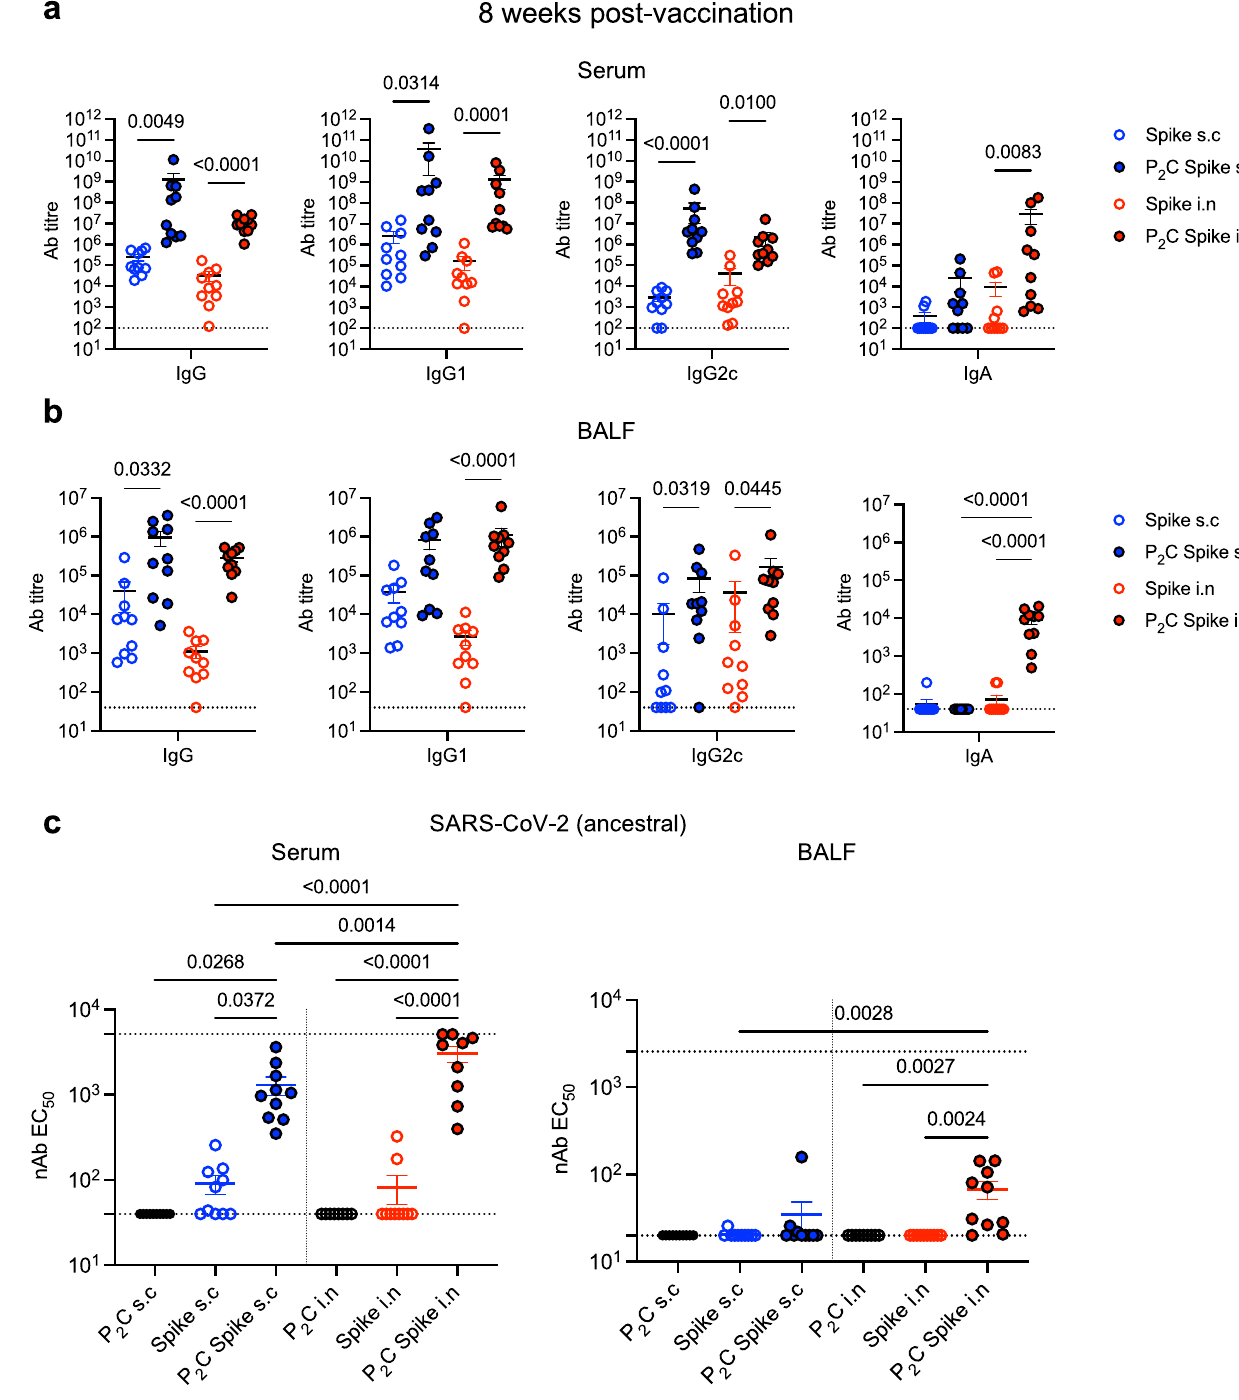
Fig. 2 | Vaccination with Pam 2 Cys Spike induces potent spike-speci fi c neu- tralizing antibody responses, which is sustained post vaccination. C57BL/6 mice were immunized with Pam 2 Cys (P 2 C; black) and/or Spike protein sub- cutaneously (s.c; blue) or intra-nasally (i.n; red) three times, two weeks apart. Immunogenicity was assessed eight weeks post fi nal vaccination. a Anti-spike IgG isotypes and IgA titres in the serum and b broncho-alveolar lavage fl uid (BALF), as determinedbyELISA. c Neutralizingantibodytitres(nAb)intheserumandBALFof